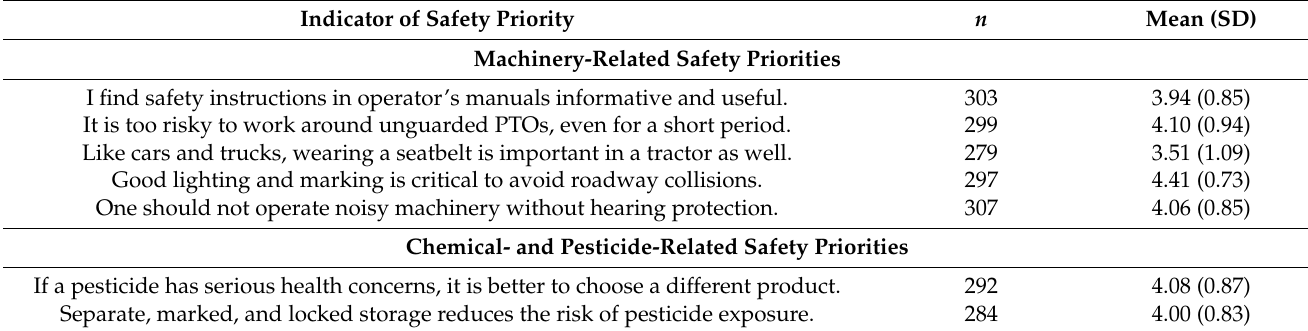
Table 4. Mean and standard deviation (SD) of self-reported safety priorities * on farm or ranch operations in the central states region of the US,